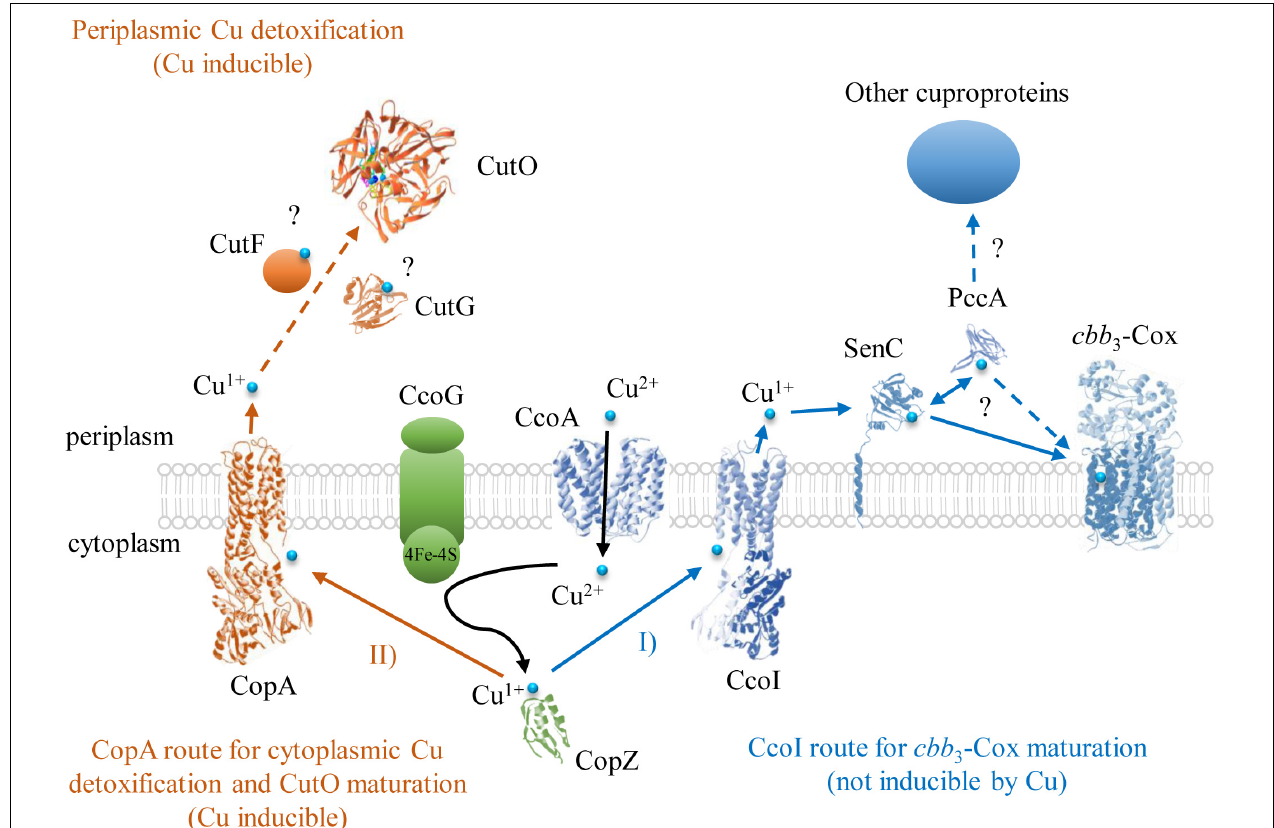
FIGURE 11 | The Cu detoxification and cuproenzyme biogenesis pathways for cbb 3 -Cox and CutO in R. capsulatus . Two Cu export routes to the periplasm have been identified so far in R. capsulatus . One of them is through the P 1B -type ATPase CcoI that exports Cu 1 + to the periplasm for cbb 3 -Cox assembly. In the periplasm, Cu is bound to SenC (or alternatively to PccA) and subsequently inserted into the catalytic subunit CcoN of cbb 3 -Cox. The other route is via the P 1B -type ATPase CopA, which has a lower affinity/higher turnover rate for Cu, and exports excess cytosolic Cu 1 + to the periplasm for CutO maturation and subsequent oxidation to Cu + 2 . In addition to the CopZ-CopA Cu delivery pathway for CutO maturation, alternative Cu supply pathways for CutO likely exist in R. capsulatus , but have not been characterized yet. Structures were retrieved from the protein database with the following IDs: 3RFU (CopA and CcoI), 6WIS (CopG for CutG), 3OD3 (CueO for CutO), 1K0V (CopZ), 3WDO (YajR for CcoA), 4WBR (ScoI/SenC), 2K70(PCuAC/PccA), 5DJQ ( cbb 3 -Cox), and depicted using